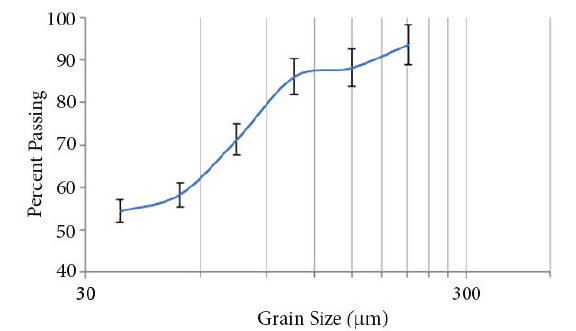
Figure 1. The size distribution of the contaminated soil by